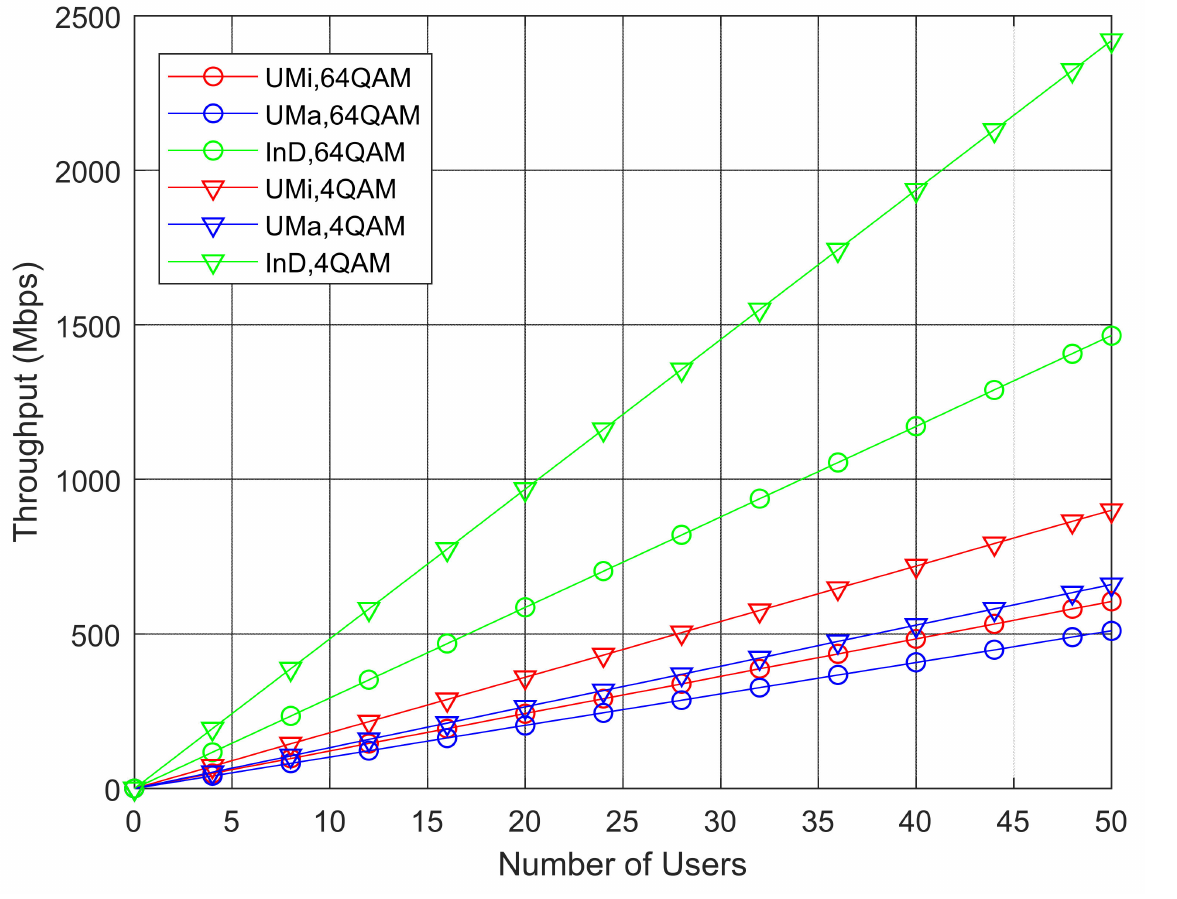
Figure 6. Throughput vs. number of users for different scenarios with N tx = 5 N u , N f = 4, N af = 3, N s = 5, N a = 2, N rx = 5, 64-QAM (11.75 bpcu per user) and 4QAM (5.75 bpcu per user), C-RAN cluster size